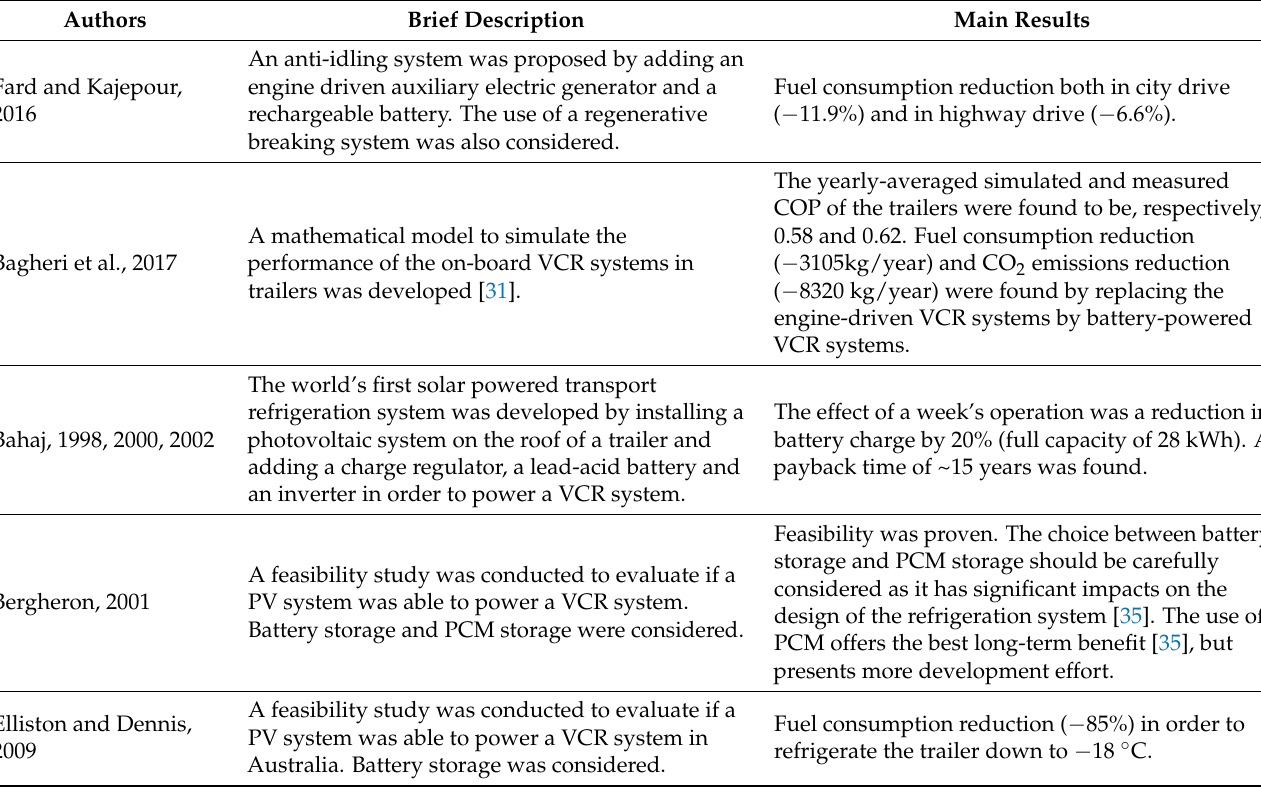
Table 2. Summary of proposed vapor compression systems in refrigerated transport